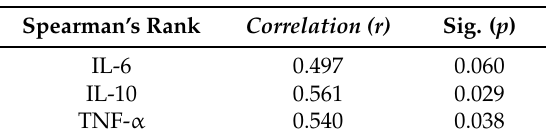
Table 5. Association between cytokine concentrations in the winter and total body mass change between fall and winter ( n =